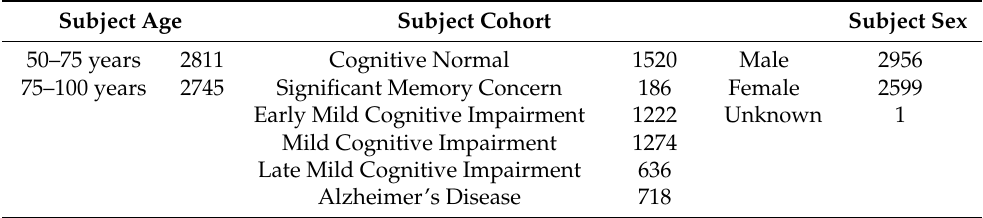
Table 1. Demographics of the